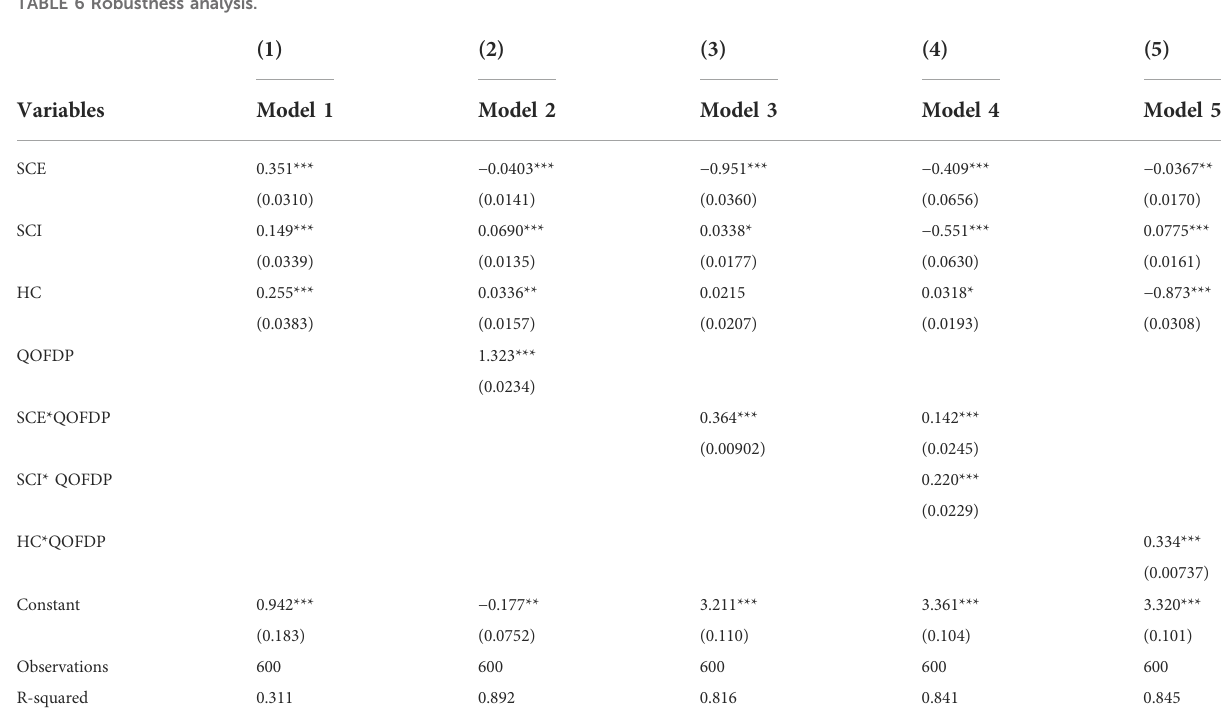
TABLE 6 Robustness analysis.